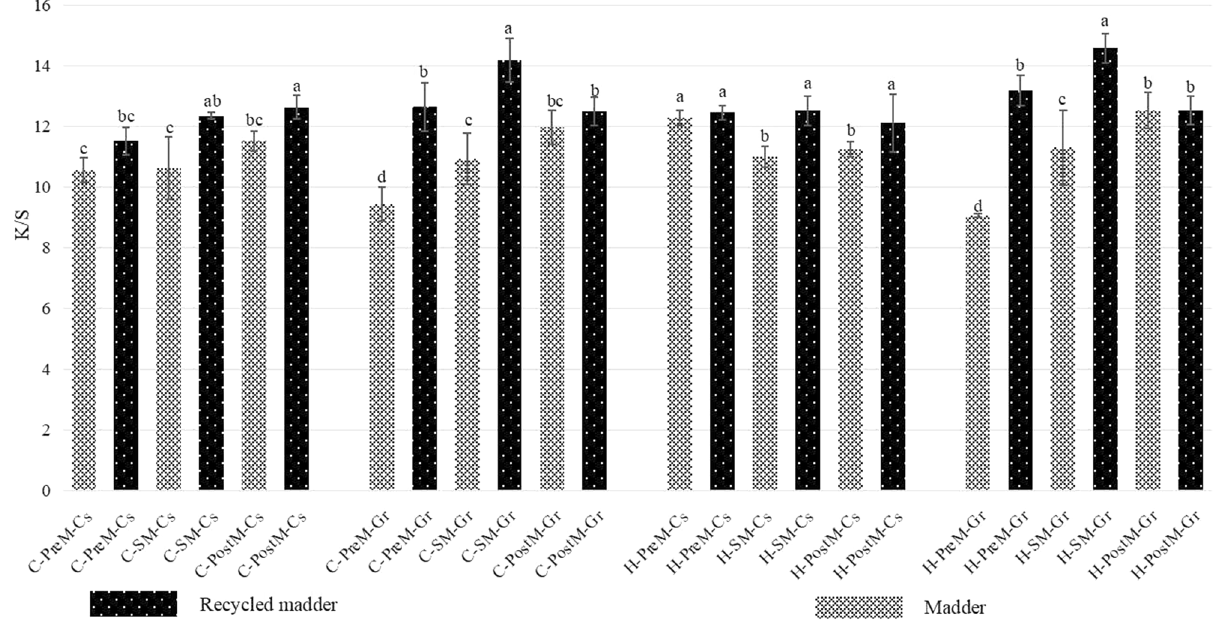
Figure 2. Comparison of color strength between madder and recycled madder with biomordants. (Biomordants: Cs = C. speciosa , Gr = Gum rosin; Fabrics: C = Cotton, H = Hemp; Mordanting method: PreM = Pre-mordanting. SM = Simultaneous mordanting. PostM = Post mordanting). Note : abcd: Different superscripts at the same row indicate significant differences ( P < 0.05). If there is the same letter mark, the difference is not significant. If there is a different letter mark, the difference is significant. Values showed the mean of triplicate it showed significantly higher K/S value of dyed cotton by recycled madder with gum rosin than madder as well as with C. speciosa in simultaneous and post-mordanting methods ( P < 0.05). Similarly, simultaneous and pre-mordanting methods presented a better K/S value of madder recycled than madder dyed hemp fabrics with gum rosin ( P < 0.05). A similar result was obtained out with C. speciosa in simultaneous and post-mordanting methods ( P < 0.05). Generally, it dramatically improves in color strength by recycled madder dyed fabrics with biomordants. Colorfastness properties. The colorfastness of dyed fabrics with madder. The colorfastness of two fabrics dyed with madder was shown in Table 5. The colorfastness of dyed samples with mordants was higher than without mordant (Indigenous madder dyeing), except that the colorfastness to perspiration and washing were slightly lower. The colorfastness to rubbing in dyed samples with biomordants was 4–5 and 5, and the staining to washing scored 4, 4–5, and 5. The colorfastness of dyed samples to perspiration was generally increased with biomordants 4, 4–5, and 5. The results showed that the color change fastness under washing was comparatively higher with mordant than without mordant. In madder dyed cotton with biomordants, color change fastness to washing was better (score 3 in post-mordanting using gum rosin) compared to results without mordants (score 1). Furthermore, it was observed that perspiration fastness was improved to 5 with C. speciosa for dyed hemp in the post-mordanting method. The colorfastness of dyed fabrics with recycled madder. The colorfastness of two fabrics with recycled madder- dyed is shown in Table 6. The results indicated that the colorfastness of recycled madder-dyed samples with mordants was strengthened, except for the color change. The colorfastness of recycled madder dyed samples with biomordants to rubbing was 4–5 and 5. Similarly, the color staining in washing and perspiration showed values 4, 4–5, and 5 with biomordant. The results indicated that the color change in washing was improved in samples with biomordants. The color change of dyed cotton fabrics in washing was better (score 3) with biomordants in the post-mordanting method than without mordant (score 1–2). The color change of dyed two fabrics in washing was improved and scored 3 with C. speciosa , while 2 with alum. The experiment results indicated that biomordants were able to enhance the colorfastness in both fabrics dyed with recycled madder. Tables 5 and 6 showed that the colorfastness of recycled madder dyed fabrics was equal to or slightly higher than the madder dyed fabrics. For instance, the washing fastness of recycled madder dyed fabrics with C. speciosa was higher than madder dyed in post mordanting method. The rubbing fastness of recycled madder dyed fabrics